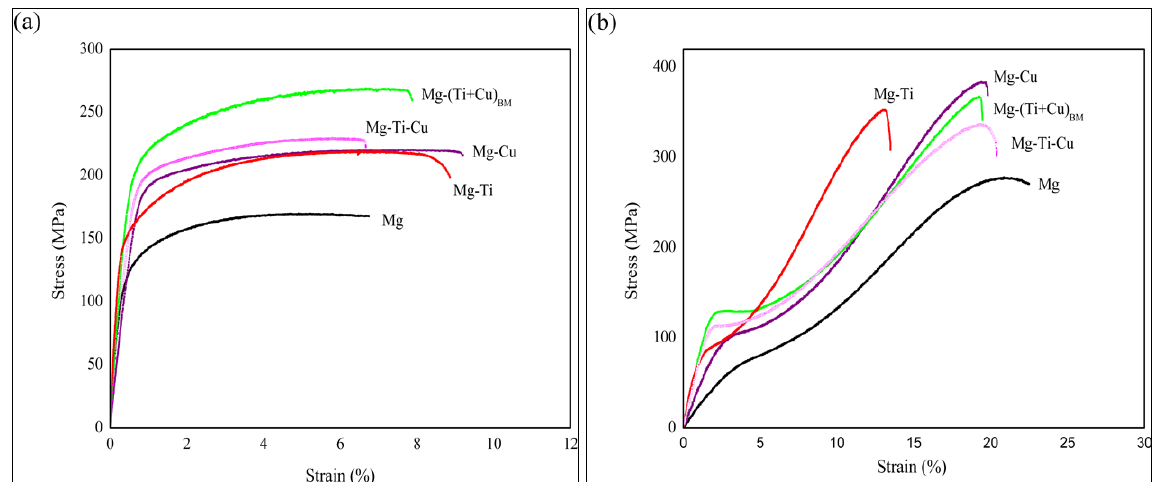
Figure 5. Engineering stress-Strain curves showing the mechanical behavior of developed Mg materials under ( a ) tension and ( b ) compression